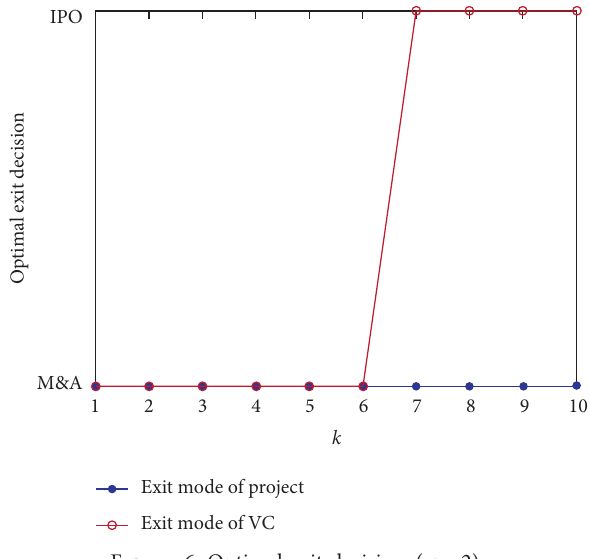
Figure 6: Optimal exit decision ( σ � 2 ) .